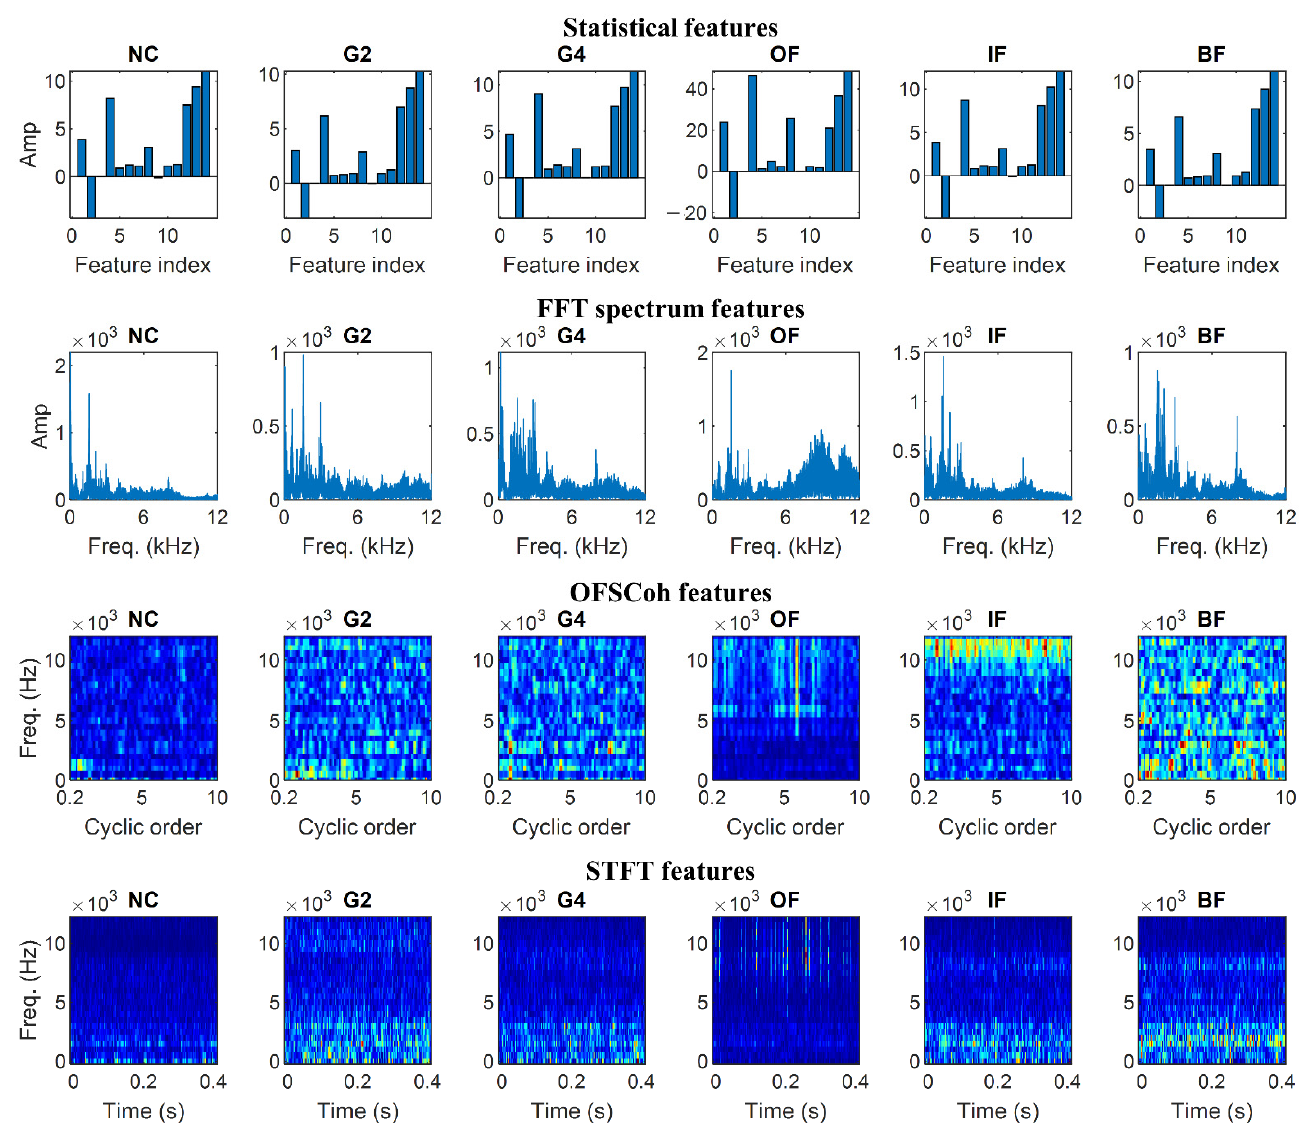
Figure A1. The Statistical, FFT spectrum, OFSCoh, and the STFT features of gearbox dataset at 1000 rpm.